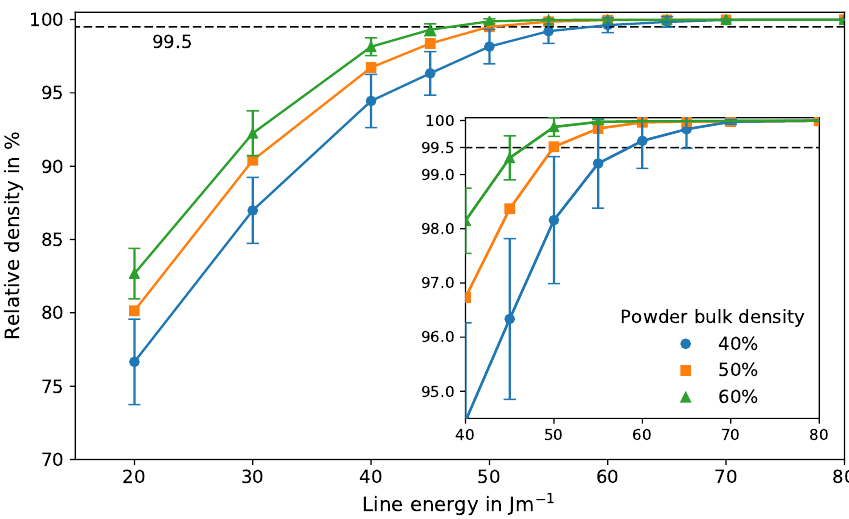
Figure 7. Relative density for different powder bulk densities for a constant scan velocity of 24m/s and different line energies between 20and 80J/m with standard deviations. For convenience, the standard deviation for the results with a powder bulk density of 50% is not shown. The inset shows the regime for a relative density between 95% and 100%. The lines serve only as a guide to the